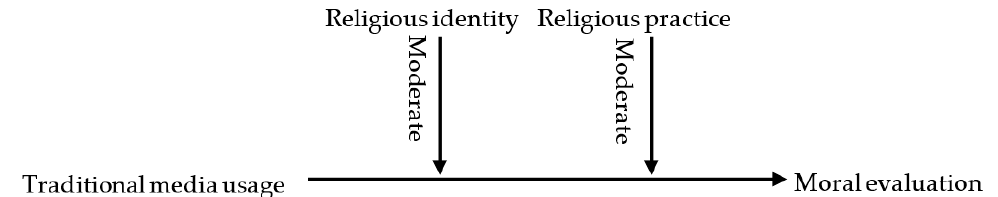
Figure 1. Research framework for the moderation role of religious identity and religious practice between traditional media usage and moral evaluation.